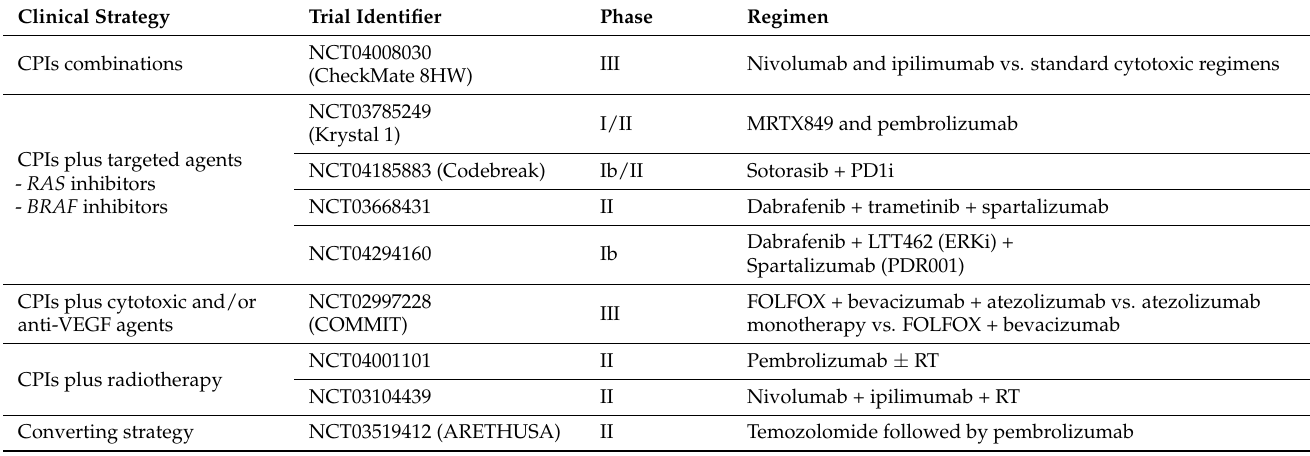
Table 1. Summary of potential clinical strategies with main ongoing and recruiting clinical trials aiming to avoid or reverse resistance to checkpoint inhibitors in metastatic colorectal cancer with particular regard to those with microsatellite instability